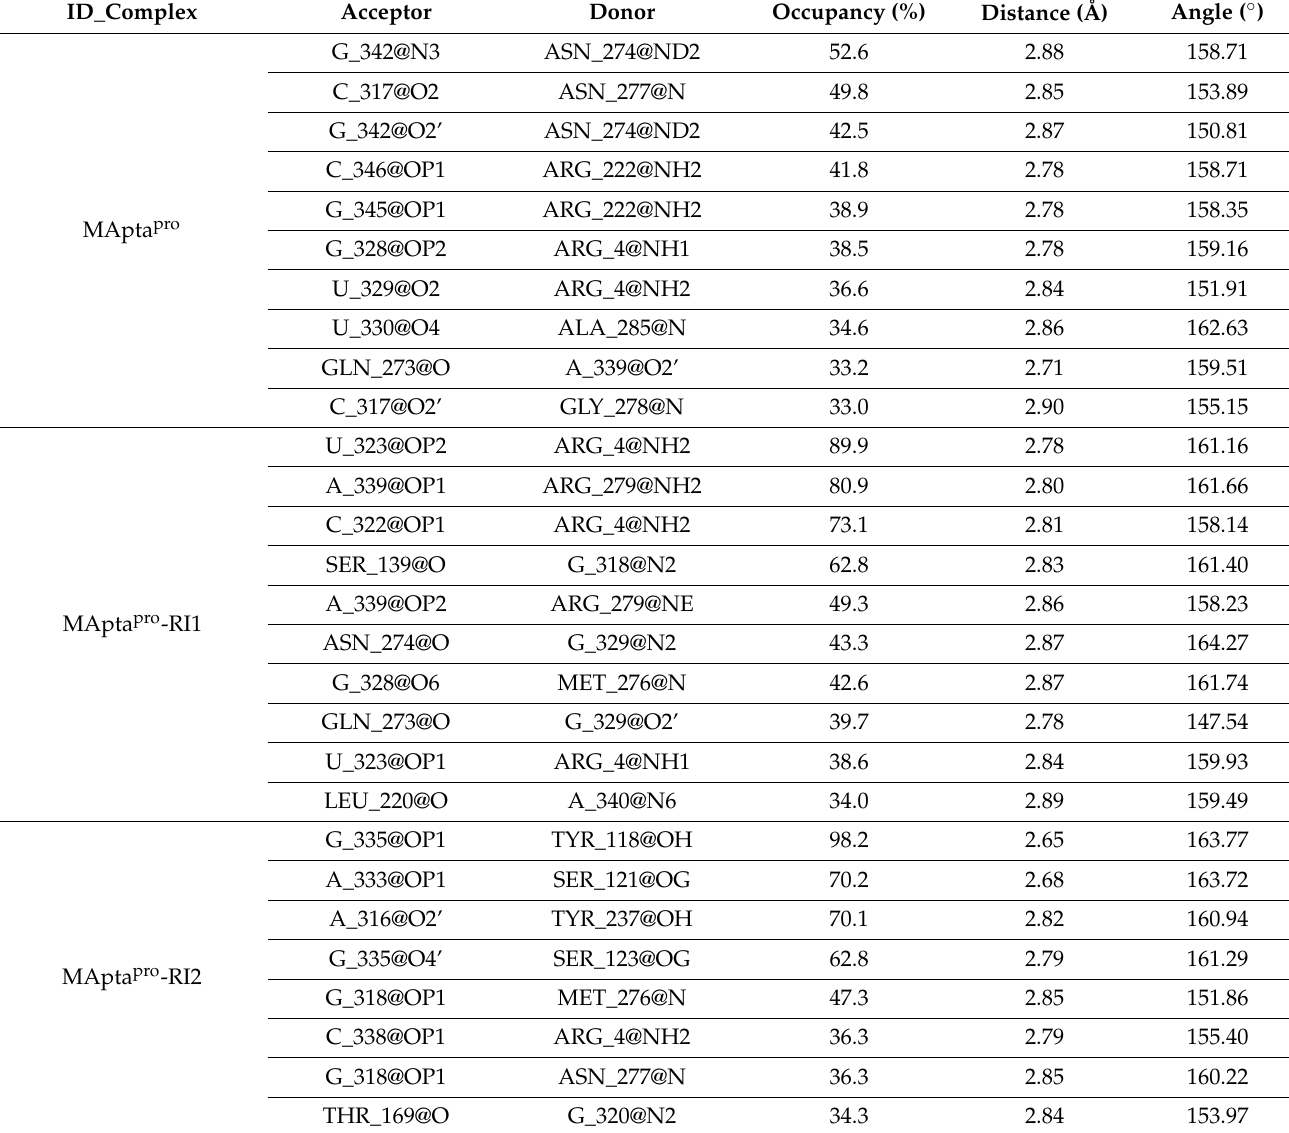
Figure 9. Total number of hydrogen bonds of ( A ) MApta pro , ( B ) MApta pro -IR1, ( C ) MApta pro -IR2 in complex with M pro protein during 100 ns molecular dynamics simulation. Table 3. The table shows the results of the ‘hydrogen bonds’ interactions which show a percentage greater than one third of the trajectory (1/3 of 1000 frames, >330, i.e., > 33%).